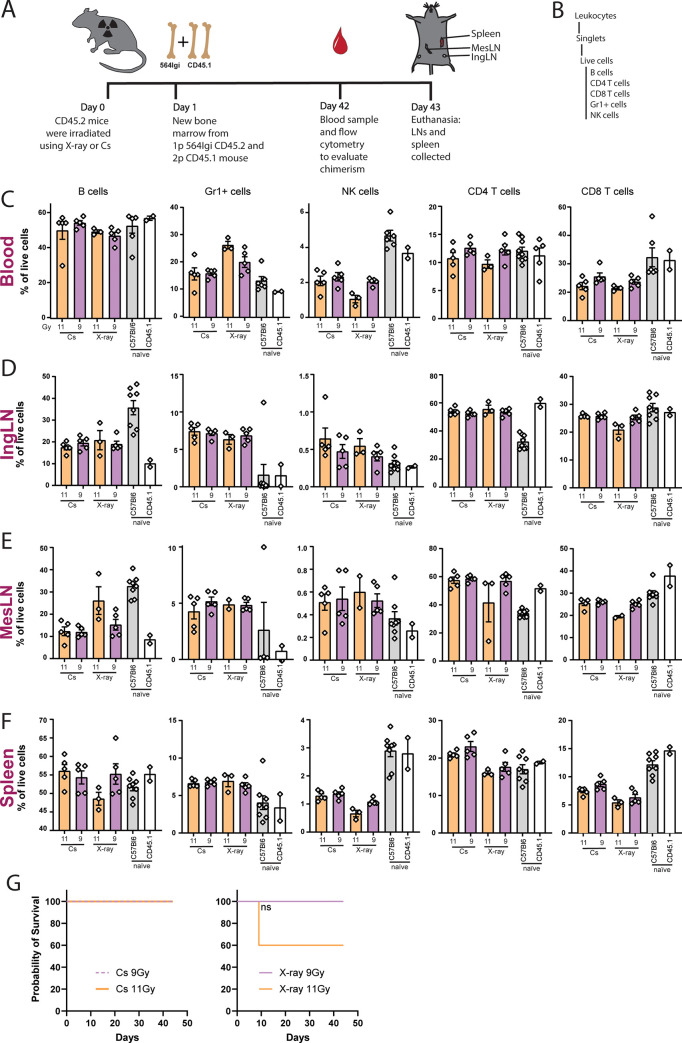
Cesium-137 (Cs-137) or X-ray irradiation affects the levels of immune cells similarly also in an autoimmune environment.A) Schematic illustration of experimental layout, where 1 part of the injected bone marrow came from the autoimmune mouse strain 564Igi and 2 parts came from wildtype donors. B) Gating tree for flow cytometry strategy, gating layout can be seen in S2A Fig. Percentages of immune cells in blood (C), IngLN (D), MesLN (E) and spleen (F) after irradiation at doses of 9 (n = 5) and 11 (n = 3 survivors, see G) Gy using either X-ray or Cs-137 irradiation. Naïve mice have not been exposed to any treatment. In all bar graphs, the bar indicates the mean and error bars indicate the standard error of mean. For blood measurements, Kruskal-Wallis test indicated significant differences between medians within B cells (P = 0.0403) and Gr1+ cells (P = 0.0289), but with no significant differences for Dunn’s pairwise comparison for any of the groups. For IngLN, the only cell population displaying significant differences between medians based upon Kruskal-Wallis test was the CD8 group (P = 0.0326), with Dunn’s post-test giving a significant difference between 11 Gy Cs-137 and 11 Gy X-ray (P = 0.0393). For spleen, there were significant differences between medians for NK (P = 0.001), CD4 (P = 0.0077) and CD8 (P = 0.0059) populations, but Dunn’s post-test came out significant only for 9 Gy Cs-137 vs. 11 Gy X-ray (P = 0.0134, P = 0.0372 and P = 0.0231, respectively). G) Survival curves for the mice after each irradiation dose. No statistically significant differences were noted based on log-ranked Mantel-Cox test with alpha = 0.05.